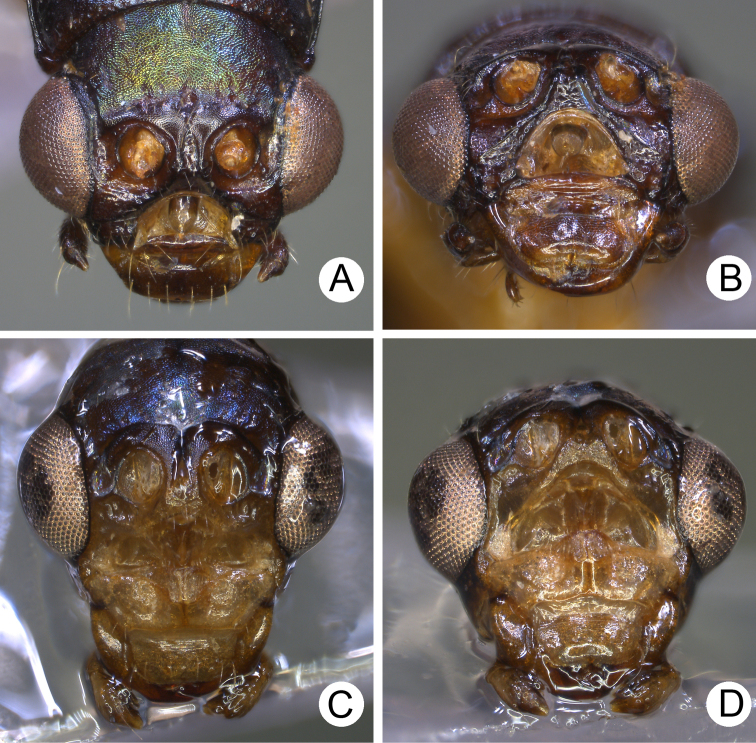
Heads of males of Pseudotheopea
gressitti sp. nov. and P.
leehsuehae sp. nov. AP.
gressitti sp. nov., dorsofrontal view B Same, front view CP.
leehsuehae sp. nov., dorsofrontal view D Same, front view.